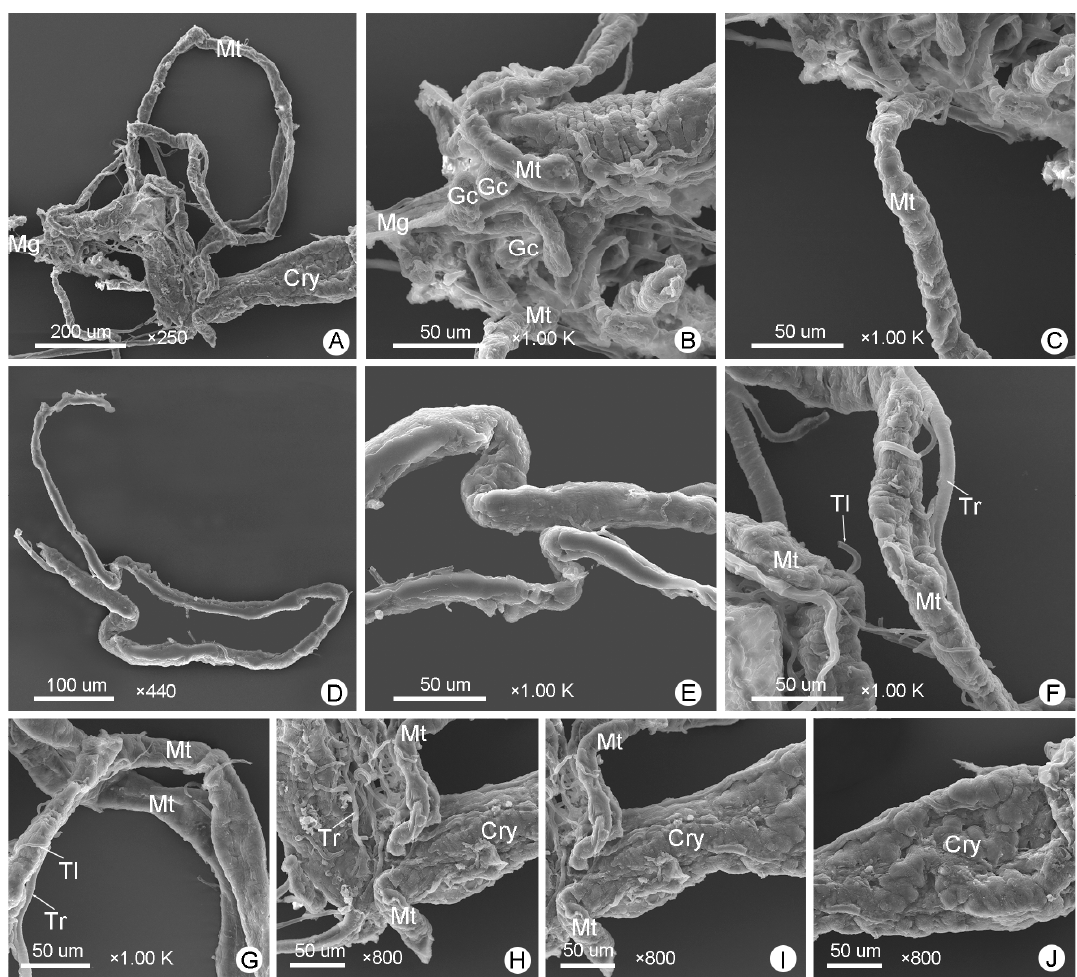
Figure 10. The Malpighian tubules of female M . ( O .) chinensis : ( A ) general view of Malpighian tubules (Mt); ( B , C ) anterior of free Malpighian tubules; ( D ) a whole free Malpighian tubule; ( E ) anterior and posterior of free Malpighian tubules present different widths; ( F ) trachea and tracheoles surrounding Malpighian tubules; ( G ) posterior of free Malpighian tubules; ( H – J ) cryptonephridial system (Cry, distal Malpighian tubules attached to the colon). Gc: gastric cecum, Mg: midgut, Tl: tracheole, Tr: trachea.